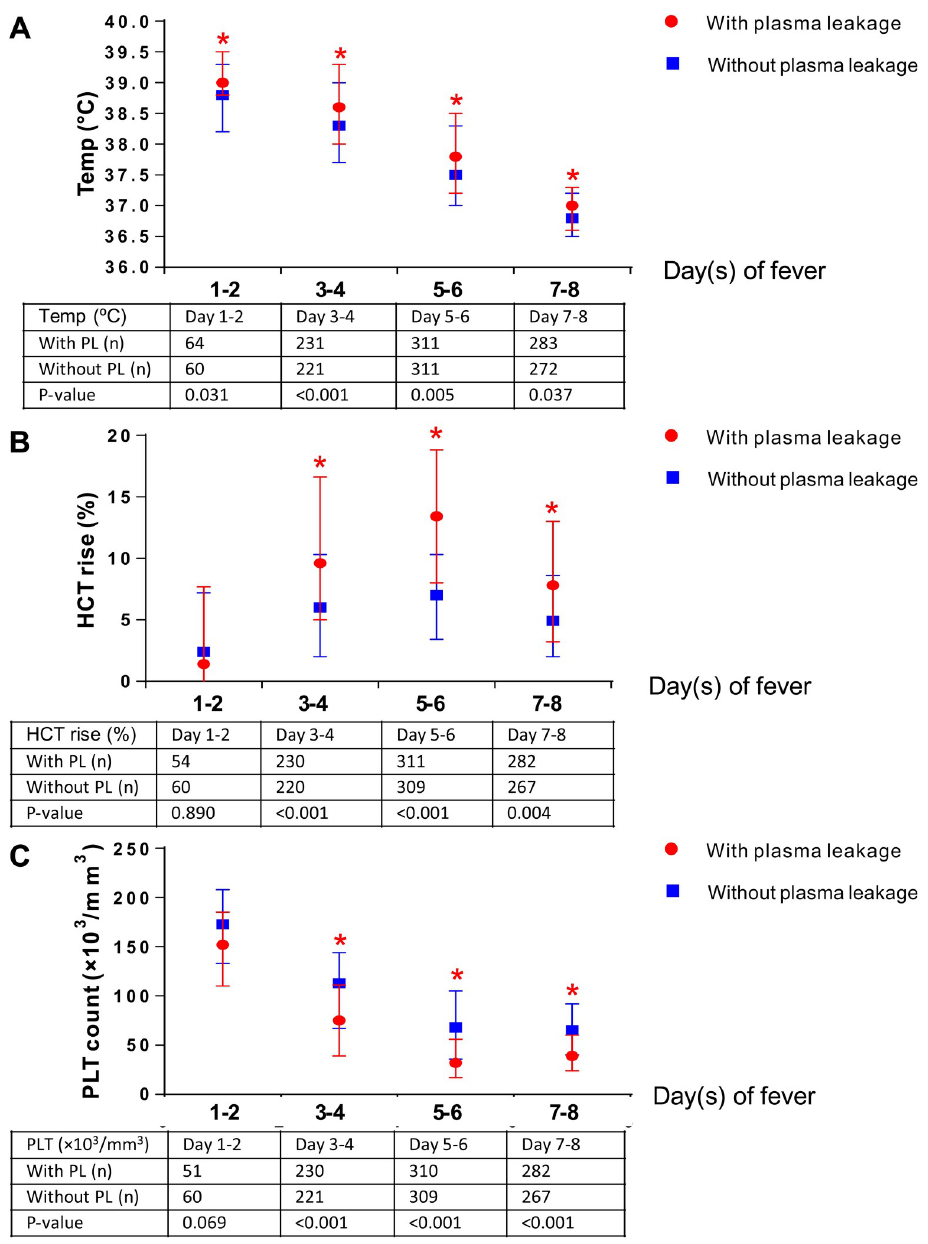
Fig 2. Changes in body temperature, hematocrit rise, and platelet count among confirmed dengue patients by combined day of fever onset. (a) The higest body temperature (˚C) by combined day of fever onset among patients with and without plasma leakage. (b). The higest hematocrit rise (%) by combined day of fever onset among patients with and without plasma leakage. (c). The lowest platelet count ( × 10 3 /mm 3 ) by combined day of fever onset among patients with and without plasma leakage. HCT, hematocrit; PL, plasma leakage; PLT, platelets; Temp, temperature. (P < 0.05). HCT rise (Tables 3 and 4) between days 3 to 7 was significantly higher among patients with plasma leakage (P < 0.05). When stratified by combined day of fever, HCT rise (Fig 2B) between days 3 to 8 of fever onset was also significantly higher among patients with plasma leakage (P < 0.05). However, PLT count (Tables 3 and 4) between days 3 to 8 of fever